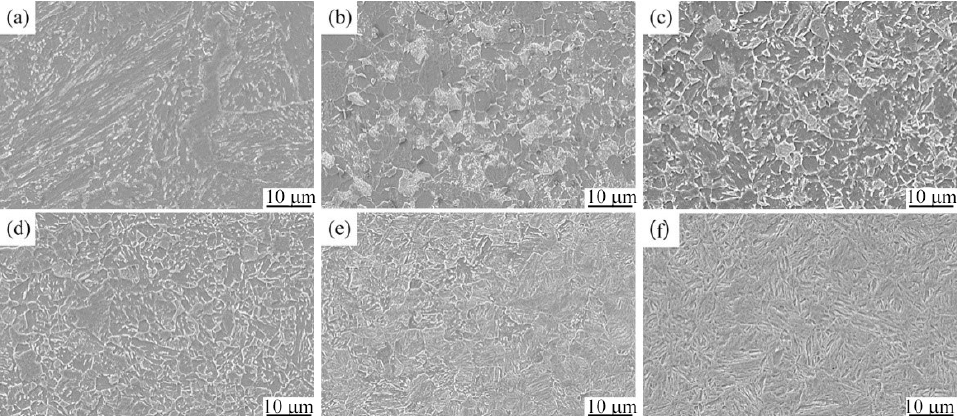
Figure 11. SEM morphology of the quenched specimens at different cooling rates ( a ) original micro- structure; ( b ) 0.05 °C·s − 1 ; ( c ) 0.1 °C·s − 1 ; ( d ) 2 °C·s − 1 ; ( e ) 10 °C·s − 1 ; ( f ) 50 °C·s − 1 .